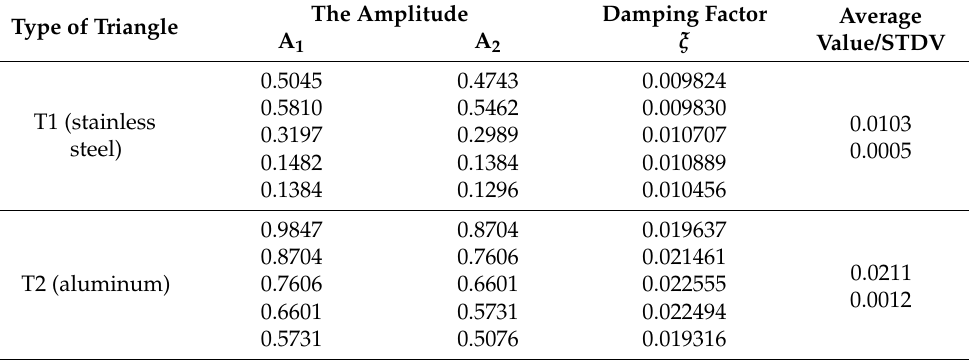
Table 4. The values of damping factor obtained experimental.